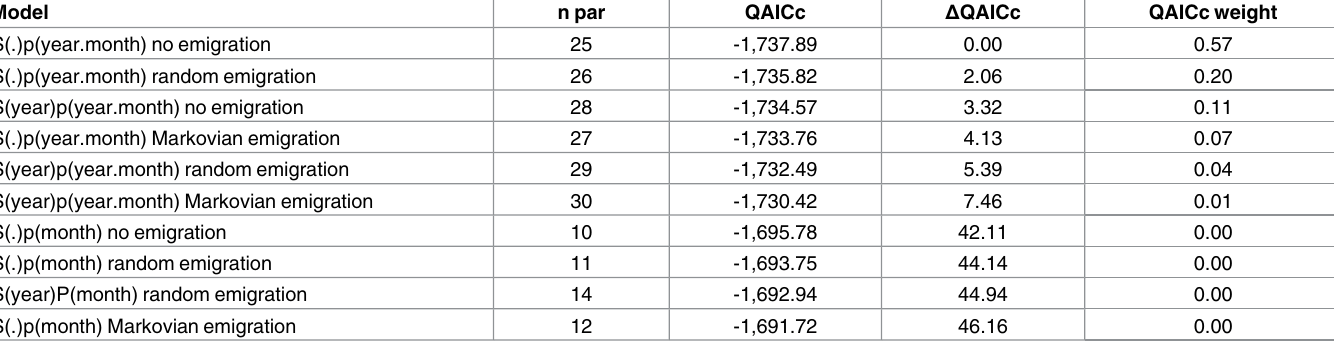
from the best-fitting model (Table 3). Models including individual heterogeneity of capture probability were not supported (data for Δ QAICc > 47 are in S3 Table). Model parameter esti- mates are shown in Table 4. For the bottlenose dolphin dataset, there was no sign of lack of fit ( χ 2 = 1.62, p > 0.5, df = 7). The best-fitting model had daily variation in capture probability, constant survival, and random temporary emigration between years (Table 5). Six more models were within 2 Δ AICc from the best-fitting model (Table 5), and therefore we resorted to model averaging considering the first six models in Table 6 and obtained the model-averaged estimates listed in Table 6. The model-averaged temporary emigration probability ( Ƴ ’) was estimated to be 0.16 (SE = 0.13). Models with Δ AICc > 4.99 are shown in S4 Table. Mark ratio, total abundance and species proportions All estimates are reported with their 95% confidence interval between parentheses. For striped, common and intermediate dolphins the mark ratios are reported in Table 4. Using these pro- portions, the cumulative total population abundance was 1,593 (1,257–2,018) in 2011, 1,272 Table 3. First ten models applied to the striped and common dolphin dataset, ranked by lowest QAICc, number of parameters (n par) and differ- ence in QAICc scores ( Δ AICc). QAICc weights indicatestrength of evidencefor a given model. S(year) = yearly variationin apparentsurvival; S(.) = no vari- ation in apparentsurvival; p(year.month) = yearly and monthly variation in capture probability;p(month) = monthly variationin capture